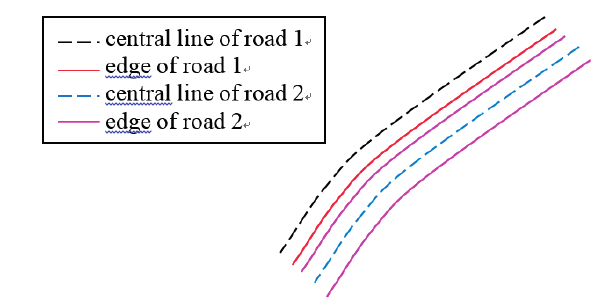
Figure 19. The road edges are generated by creating parallel lines from the central lines of the road according to the calculated road width.